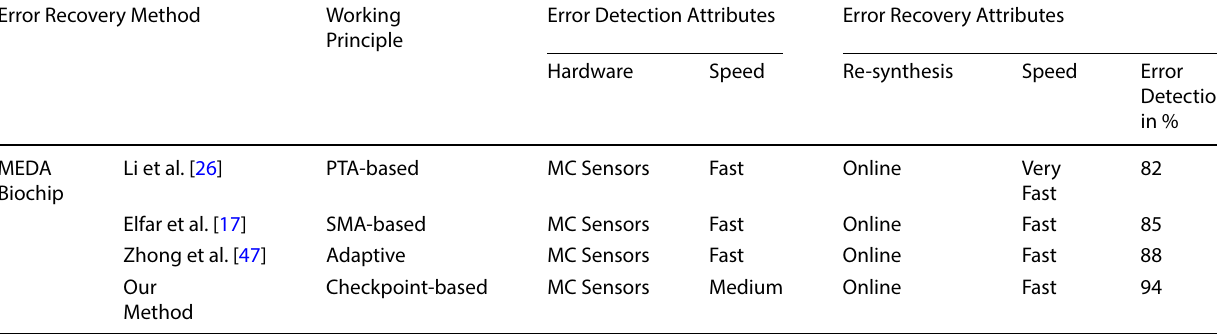
Table 12 Comparative study of error detection rate with other methods by the checkpoints placed on RBS Error Recovery